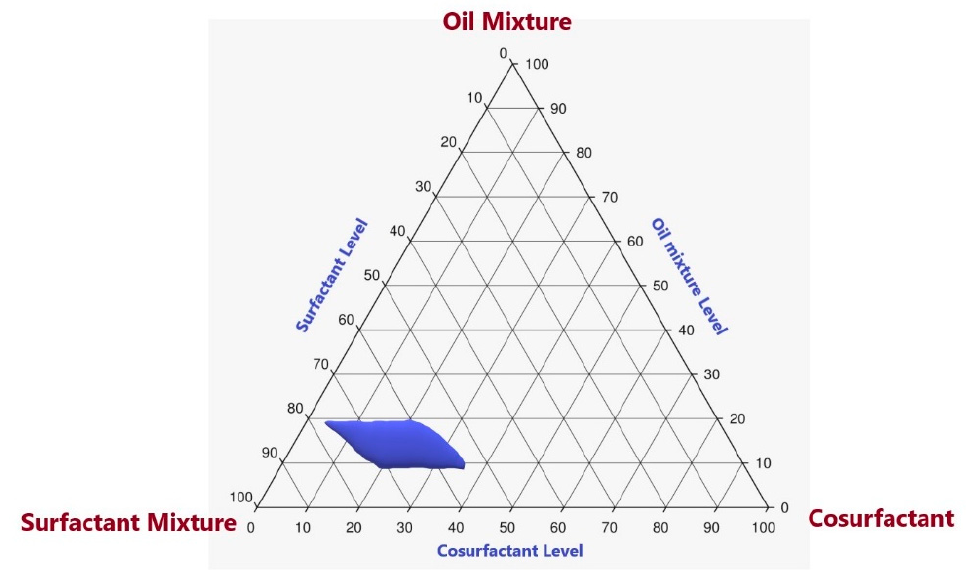
Figure 1. Pseudoternary-phase diagram in formulation components. The oil mixture contained peppermint oil (PO) and Labrafac Lipophile WL 1349 (MCT) in the PO:MCT ratio of 1:1. The surfactant mixture contained Tween 80 and Span 80 with an HLB value of 12. PEG 400 was the co-surfactant.